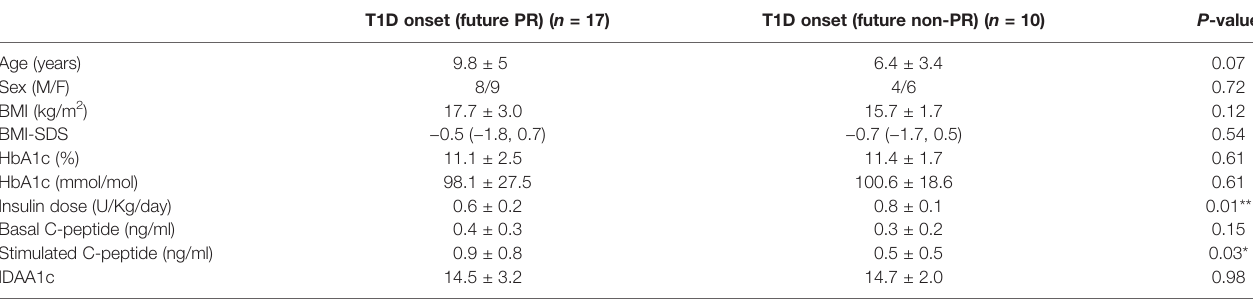
TABLE 2 | Clinical features and metabolic data of patients with T1D included in the PR predictive model study at disease onset separated by future remitters and